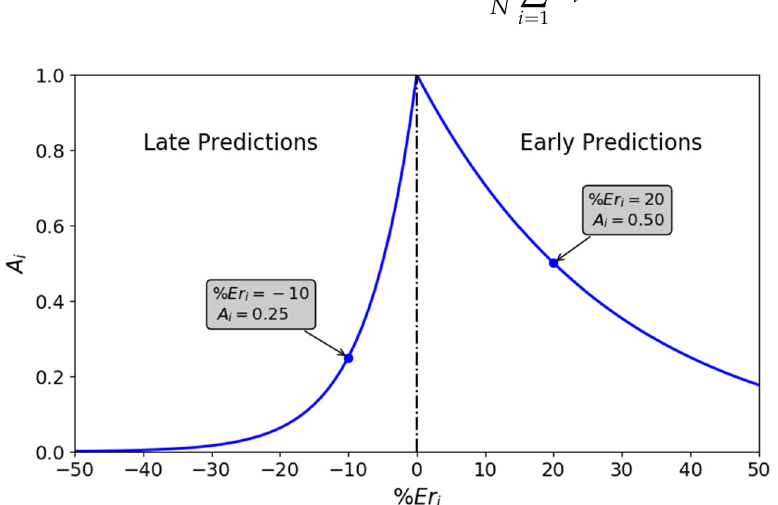
Figure 15. Scoring function for RUL estimation. Table 6. Summary of RUL estimation results for Bearing1-3, 1-4, 1-5, 1-6, and 1-7.